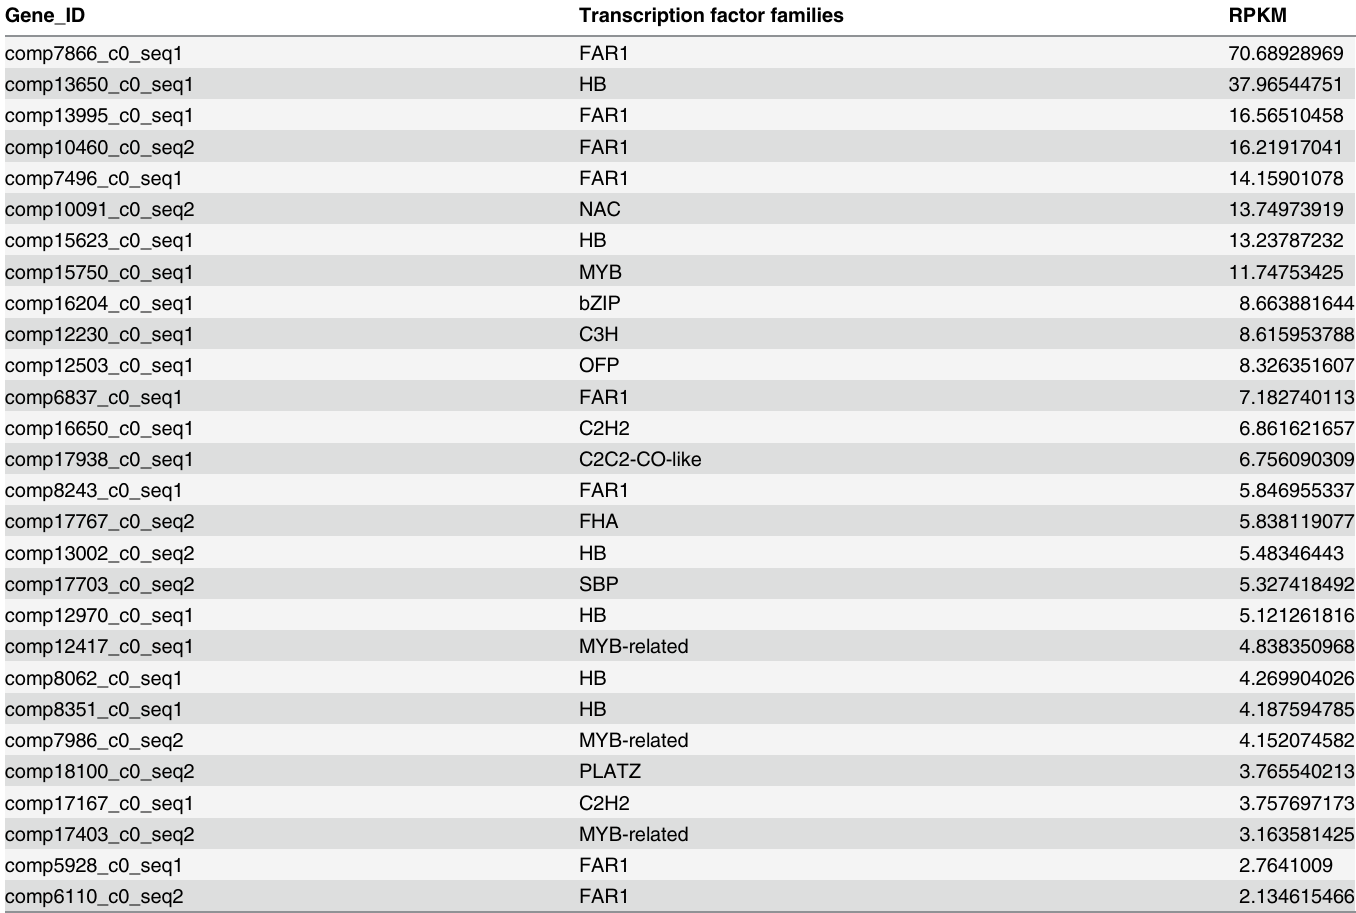
Table 3. Twenty-eight specifically or preferentially expressed unigenes in the selfed ovules of Xanthoceras sorbifolium encode for the putative transcription factors belonging to 12 different families. RPKM: Reads per Kilobase per Million reads.